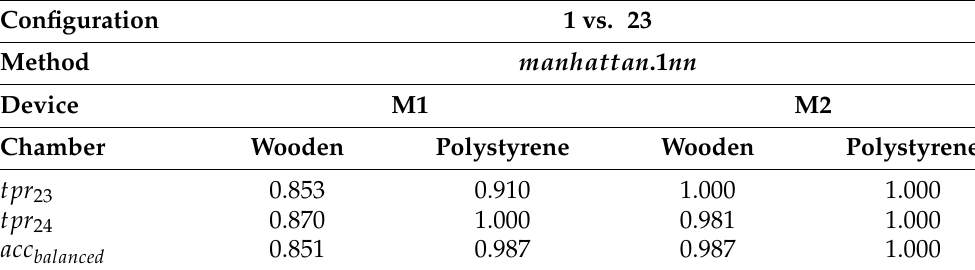
Table 10. The obtained tpr values for class 1 and 23, and acc balanced in validation tests of 5 × MCCV-5 in the comparison of 1 vs.23 for the canberra .811 test, device M1 and M2.